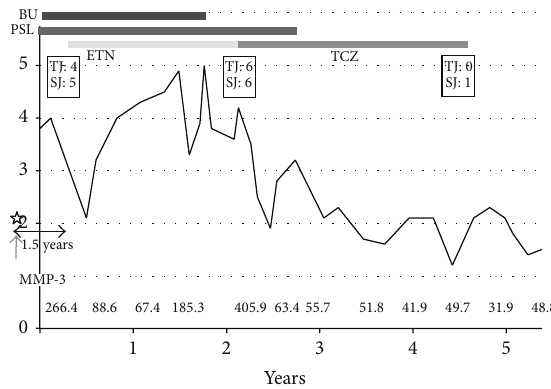
Figure3:Summaryoftheclinicalcourseofcase3.DAS28-CRPDis- ease Activity Score assessing 28 joints with C-reactive protein. SASP: salazosulfapyridine, PSL: prednisolone, MTX: methotrexate, MZR: mizoribine, BU: bucillamine, ADA: adalimumab, TCZ: tocilizumab, and MMP-3: matrix metalloproteinase-3. The asterisk shows the cessation of smoking. TJ means tender joint counts and SJ means swollen joints counts for the assessment of DAS